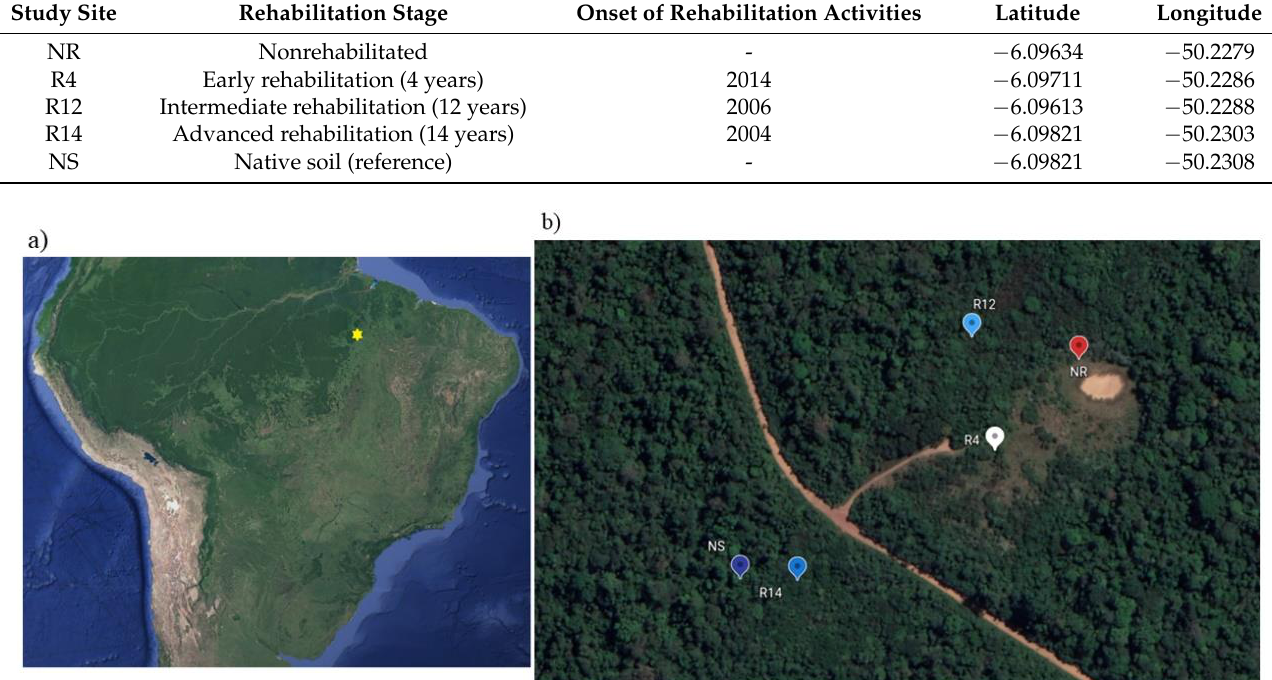
Figure 1. ( a ) A hexagonal spot points to the Carajás National Forest, Parauapebas — PA, Brazil. ( b ) Five spots show where a sample of each rehabilitation stage was collected; the image was taken from 1.726 m altitude. Google Earth images. For the site codes, please refer to Table 2. site codes, please refer to Table